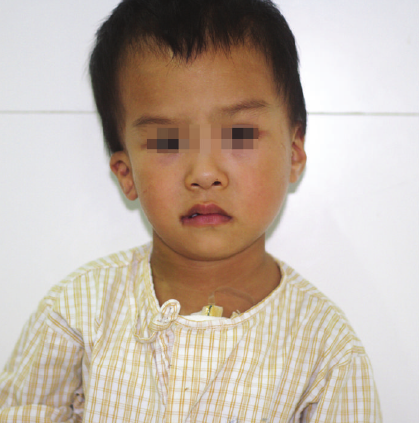
Figure 1: Frontal facial view showing facial asymmetry affecting the right side including microtia and downslanting zygomatic arch, jaw bone, mouth, and lips.